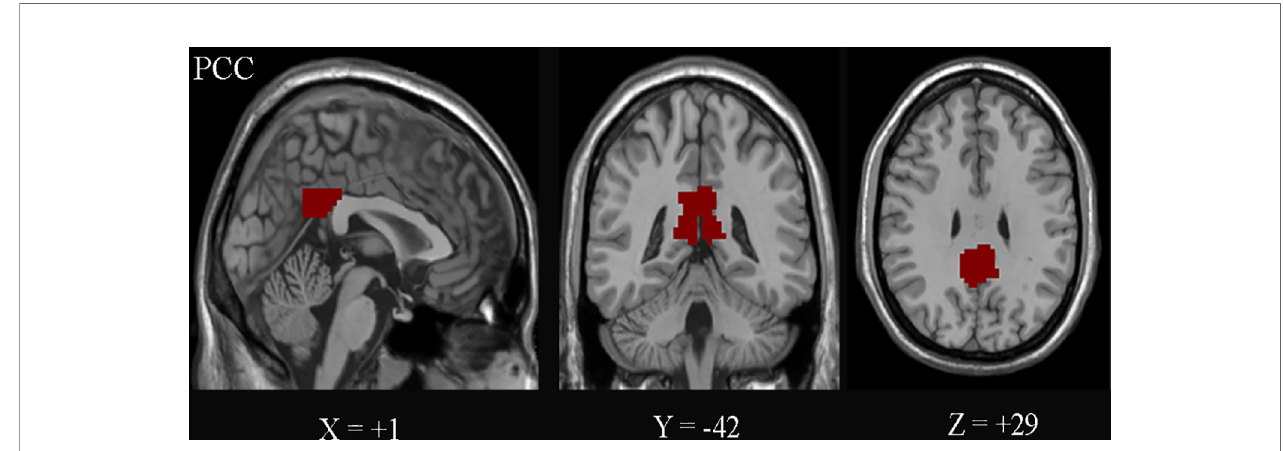
FIGURE 2 | The posterior cingulate cortex (PCC) on the Montreal Neurological Institute (MNI) coordinates (+1, − 42, and +29) is